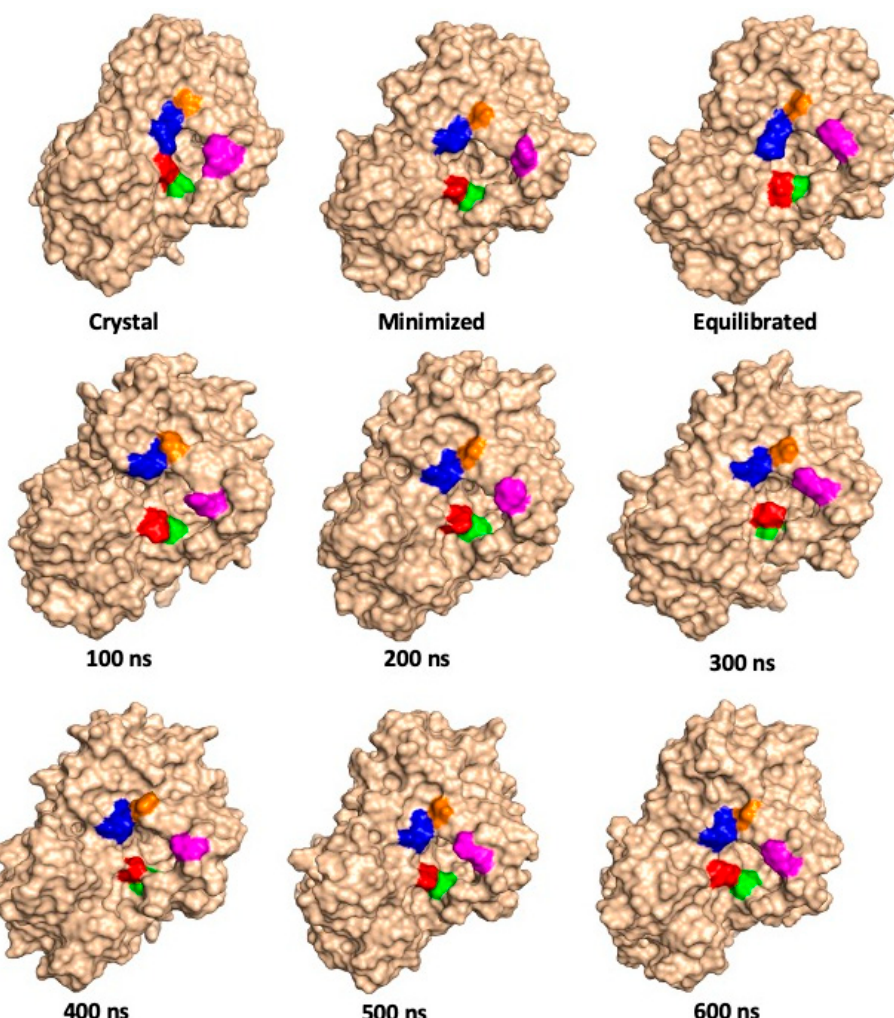
Figure 5. Illustration of the position of selected hydrophilic residues of P450-TT enzyme involved in the substrate channel, as observed in the X-ray crystal structure, minimized and equilibrated structures (see Methods), and at periodic times during the 600.5 ns MD simulations, performed at 300 K. Color code: Gln66 = red; Ser67 = green; Arg76 = magenta; Arg88 = blue, and Asn87 = orange.